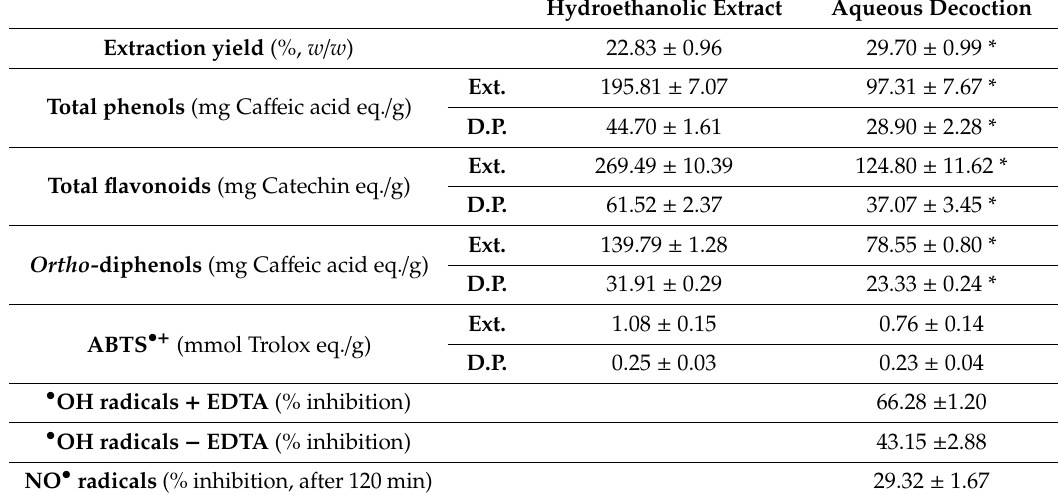
(Table 1; HE: 44.70 ± 1.61 and AD: 28.90 ± 2.28 mg CA eq. / g